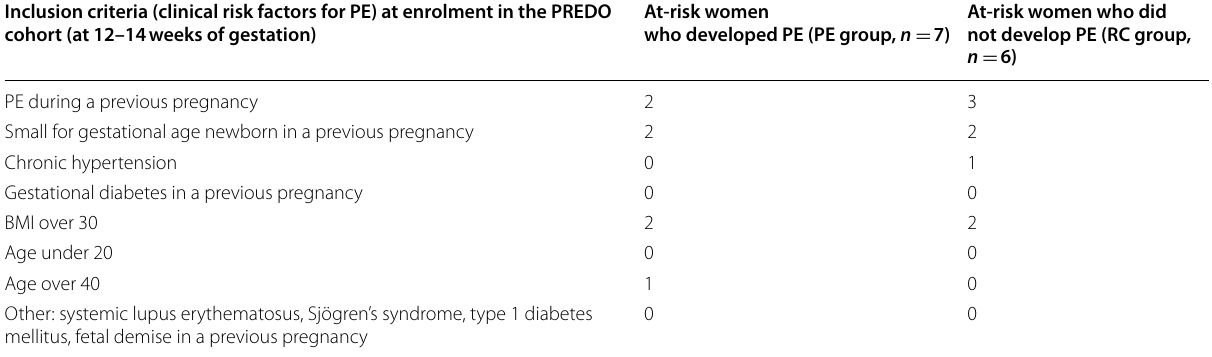
Table 1 The clinical risk factors for PE the women in this study had when enrolled in the prospective PREDO cohort Inclusion criteria (clinical risk factors for PE) at enrolment in the PREDO cohort (at 12–14 weeks of gestation)